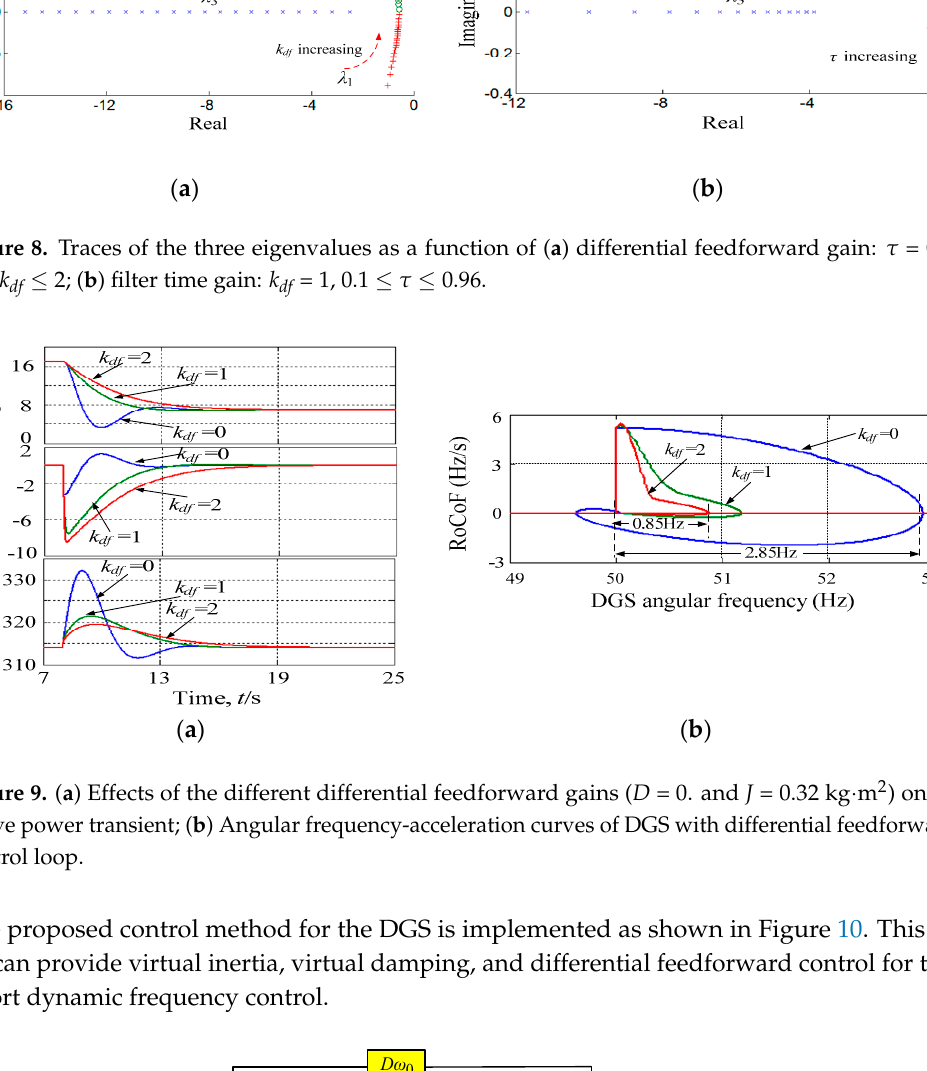
Figure 8. Traces of the three eigenvalues as a function of ( a ) differential feedforward gain: τ = 0.3, 0 ≤ k df ≤ 2; ( b ) filter time gain: k df = 1, 0.1 ≤ τ ≤ 0.96.